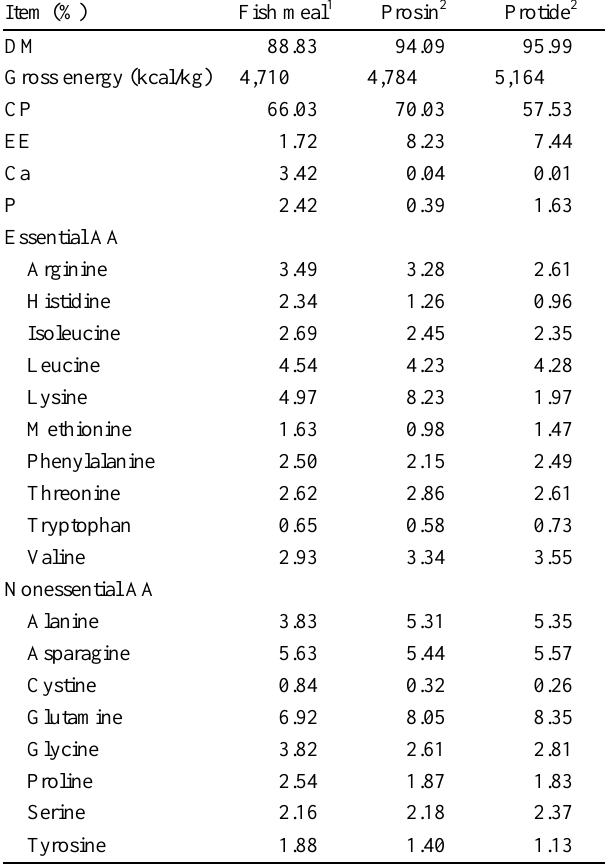
Table 1. Analyzed nutrient composition of fish meal and single- cell proteins (Prosin and Protide) (as-fed basis) Item